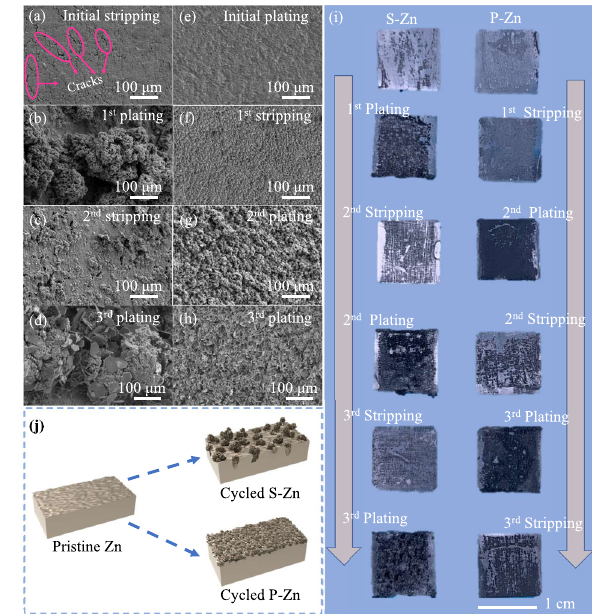
Fig. 4 Ex situ microscopy investigation of Zn metal electrodes after stripping or plating. a – d Side view SEM images of the Zn metal electrode after the initial stripping, the following 1st plating, 2nd stripping, and the 3rd plating at an angle of 45°; e – h side view SEM images of the Zn metal electrode after initial plating, the following 1st stripping, 2nd plating, and the 3rd stripping; i photographic picture of the disassembled Zn metal electrode; j schematic of the morphology evolution of cycled S-Zn and